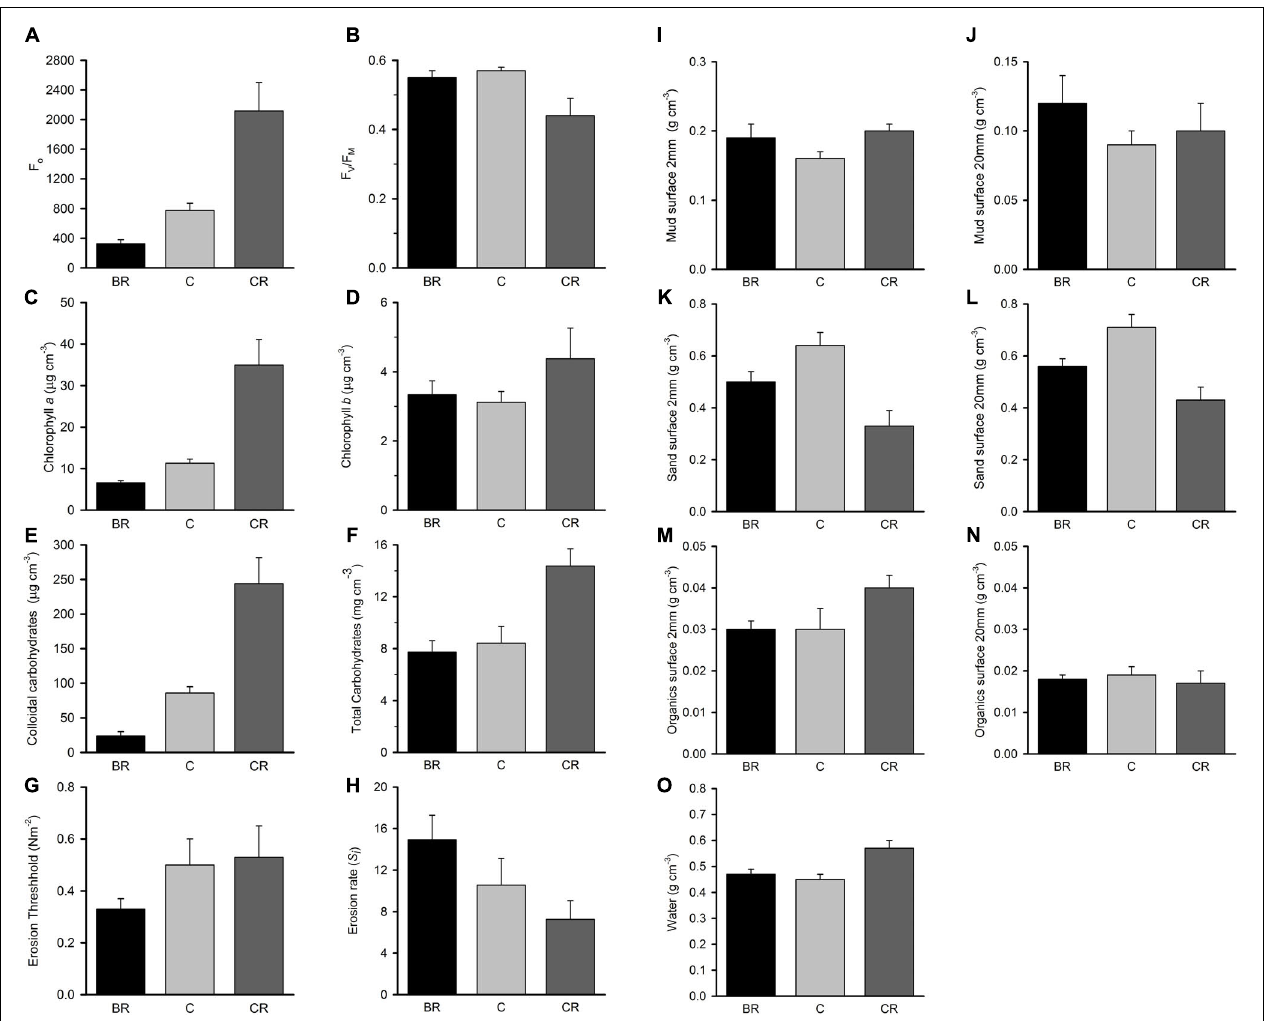
FIGURE 8 | Tambourine Bay properties of sediment after 3 months, mean (SE) for panel (A) F o , (B) F v / F m , (C) chlorophyll a , (D) chlorophyll b , (E) colloidal carbohydrates, (F) total carbohydrates, (G) erosion threshold, (H) erosion rate, (I) mud from 2 mm deep core, (J) mud from 20 mm deep core, (K) sand from 2 mm deep core, (L) sand from 20 mm deep core, (M) organics from 2 mm deep core, (N) organics from 20 mm deep core, and (O) water from 2 mm deep core. F o and F v / F m measured with a PAM (unitless); erodibility measured with a CSM, erosion threshold (N m − 2 ), erosion rate (dimensionless); all other measures are mass density (wt per cm − 3